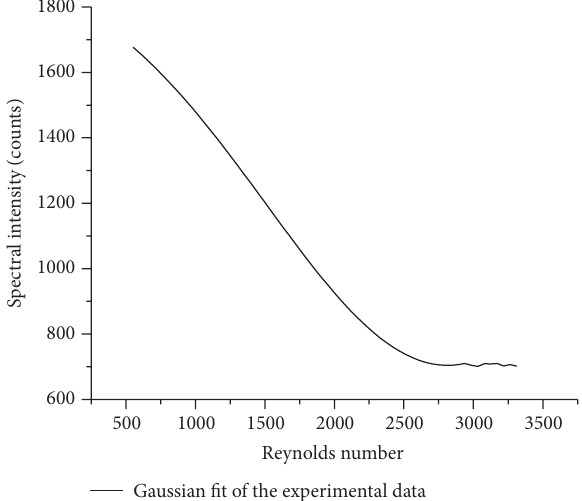
Figure 4: The spectral intensity variation of the fitted Gaussian at higher Reynolds numbers.